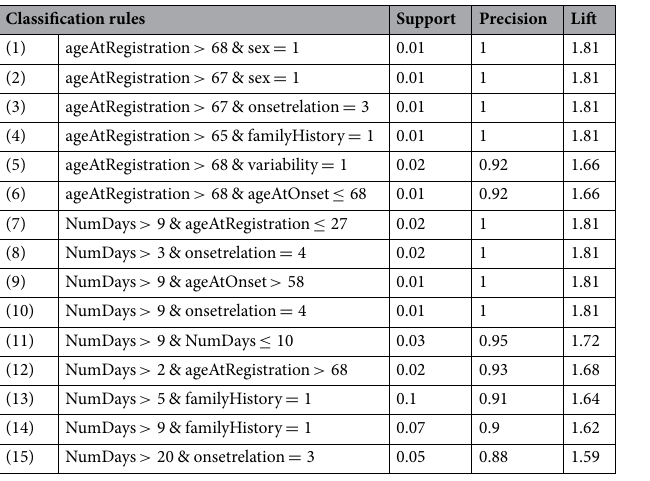
Table 6. Classification rules for Return = Yes over TSCHQ and NumDays with the following parameter settings: support lower boundary = 0.01 , maximum rule length = 2 , maximum number of child rules = 800 , minimum gain in precision = 0.01 , p-value < 0.05 (without correction for multiple